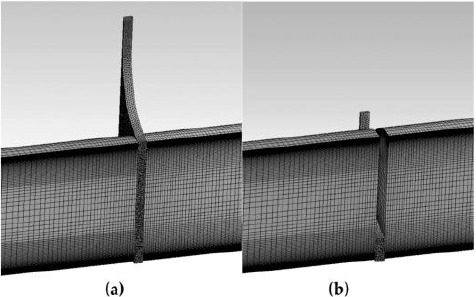
Figure 4. Dynamic mesh method grid cut in half: ( a ) before valve movement; ( b ) at t = 4 s close to the end of valve closure .